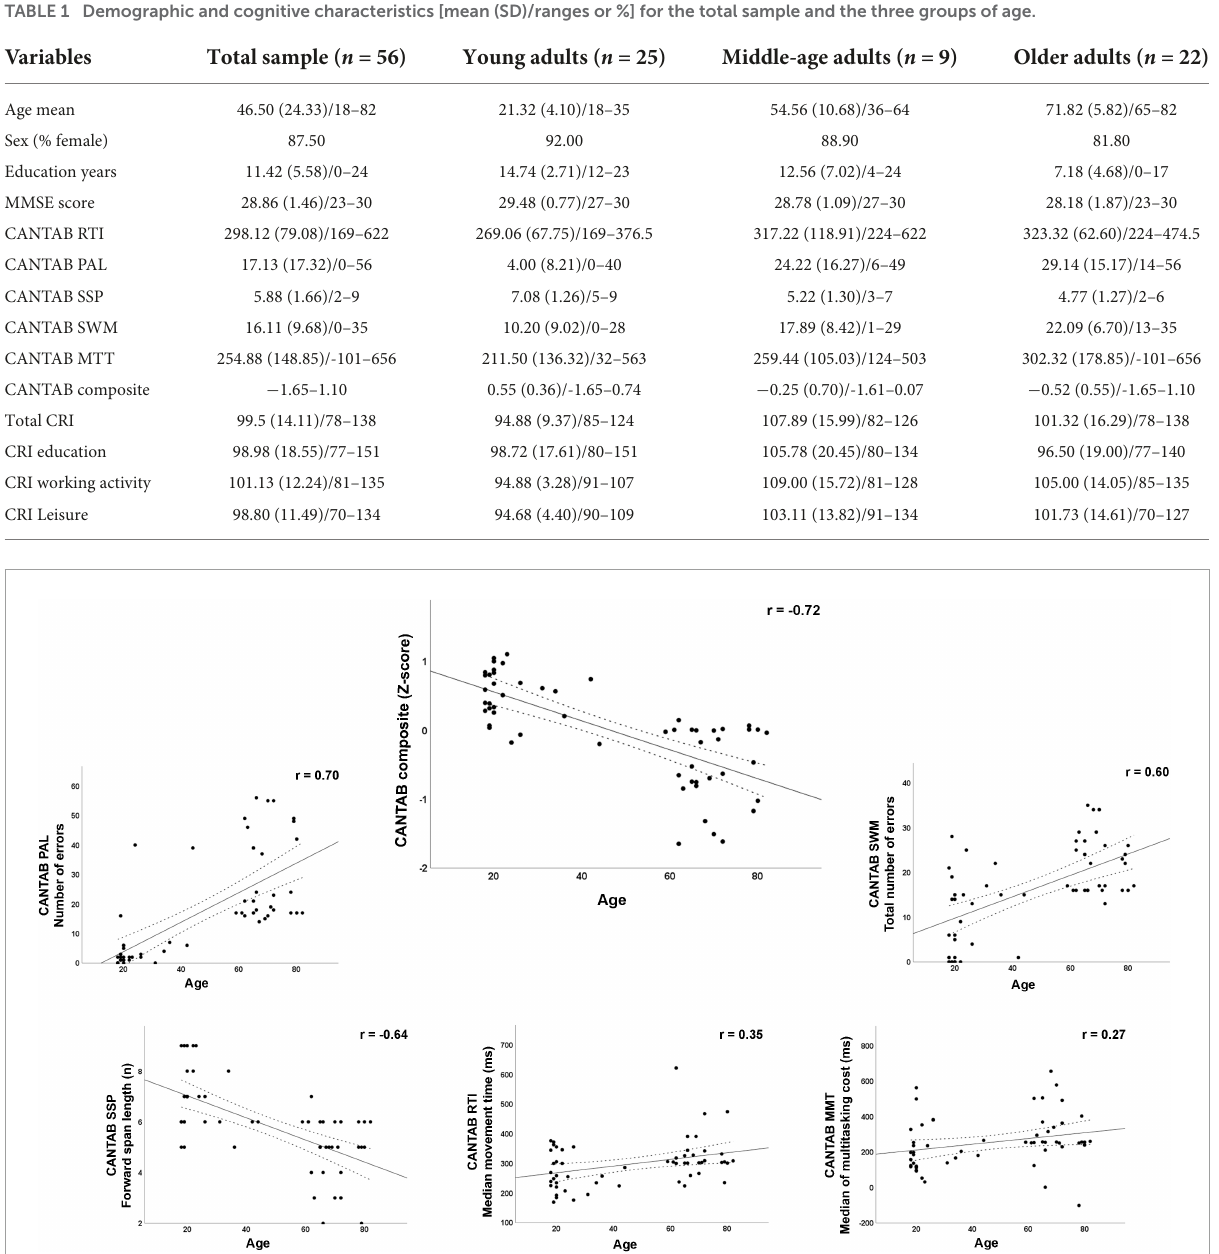
FIGURE1 Scatterplots with Pearson’s r for the relationship between age and cognitive function measured through the CANTAB subtests and the composite score. PAL, Paired Associates Learning test; SSP, Spatial Span test; RTI, Reaction Time test; SWM, Spatial Working Memory test; MMT, Multitasking